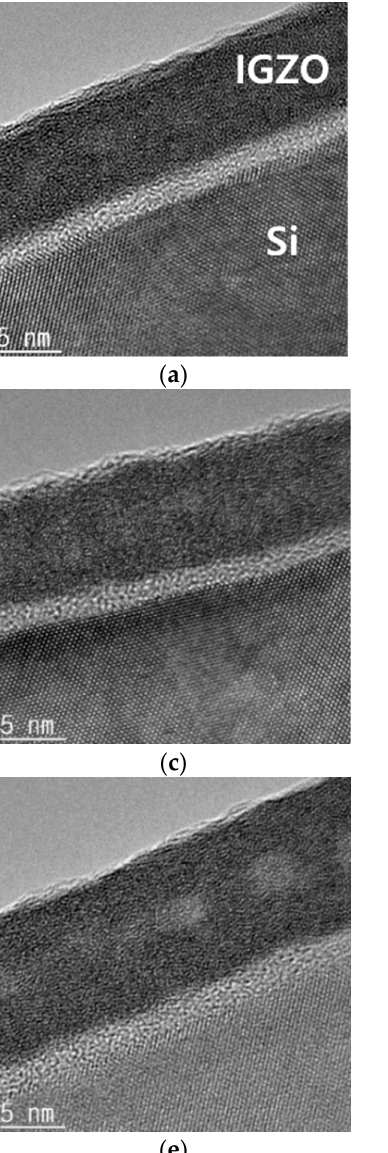
Figure 4. Cross-section high resolution transmission electron microscopy (HRTEM) images of IGZO films on Si wafers annealed by ( a ) deep UV photochemical activation; thermal annealing at 350 °C for ( b ) 20 and ( c ) 100 min; intense pulsed light (IPL) annealing width pulse width of 2 ms and ( d ) 10 and ( e ) 15 shots.